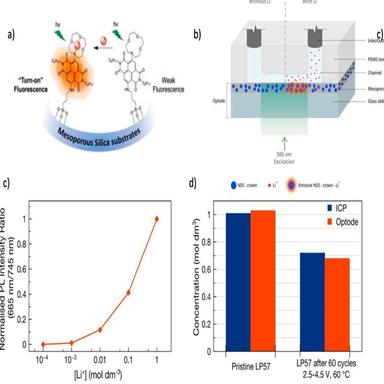
.1. Scheme for functionalizing mesoporous silica substrate with lithium sensing fluorophore (a). Microfluidic channel for measuring the bulk lithium concentration of electrolytes and diffusion constants of lithium salts (b). Thin film photoluminescence of the functionalized mesoporous silica substrate as a function of lithium concentration (c). Lithium concentration measurements of pristine and post-cycled electrolytes using fluorescent sensor and ICP (d).